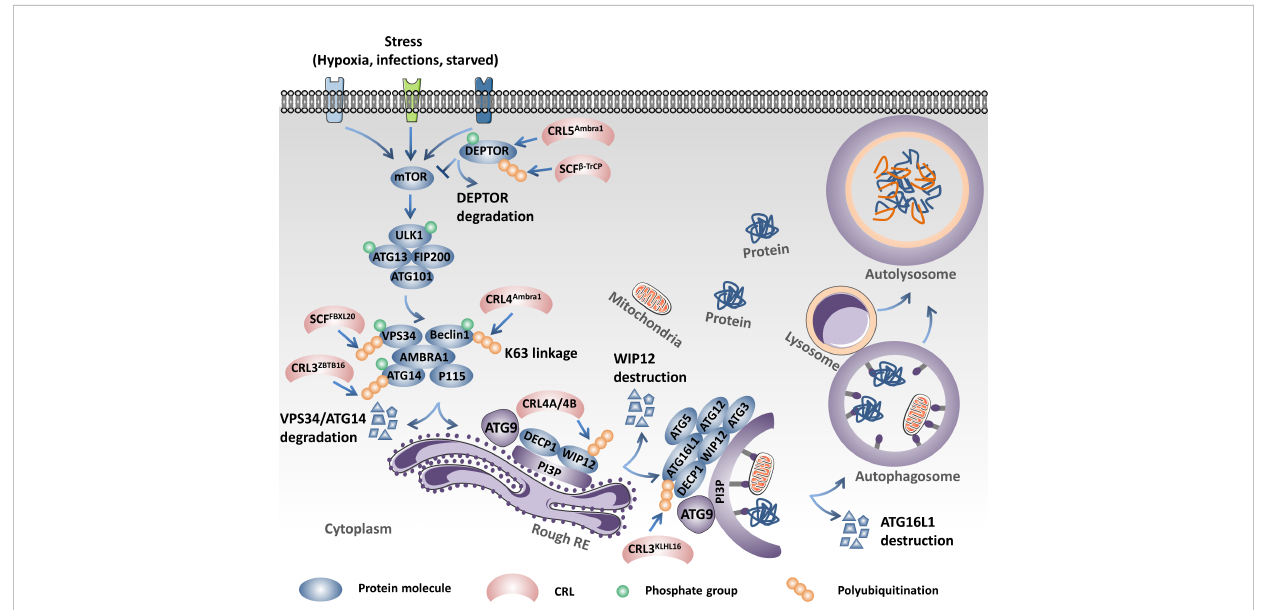
FIGURE 3 Cullin-RING ligases (CRLs) regulate the initiation and elongation of autophagy. Ambral1 binds with and inhibits Cul5, which leads to the accumulation of the mammalian target of rapamycin (mTOR) inhibitor DEPTOR, inactivating autophagy. However, SCF b -TrCP mediates the ubiquitination and proteolysis of DEPTOR and activates autophagy. SCF FBXL20 facilitates the ubiquitination and degradation of VPS34 depending on the phosphorylation catalyzed by cyclin-dependent kinase (CDK). CRL4 Ambra1 catalyzes the K63 linkage ubiquitination of Beclin1 under stimulation of starvation and promotes the interaction between Beclin1 and VPS34. CRL3 ZBTB16 speci fi cally promotes the ubiquitination and degradation of ATG14L. CRL4A- and CRL4B-based E3 ligases could induce the destruction of WIPI2 through the 26S proteasome to inhibit autophagosome biogenesis. CRL3 KLHL16 promotes the K48 linkage ubiquitination and degradation of ATG16L1 and in fl uences the elongation of the